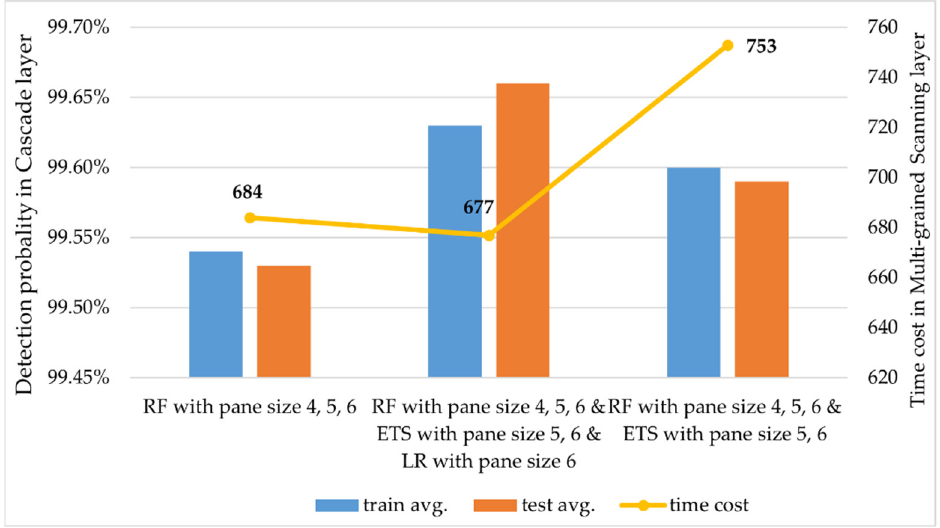
Figure 15. C ascade layer and time cost in the multi-grained scanning layer. Figure 15. Cascade layer and time cost in the multi-grained scanning